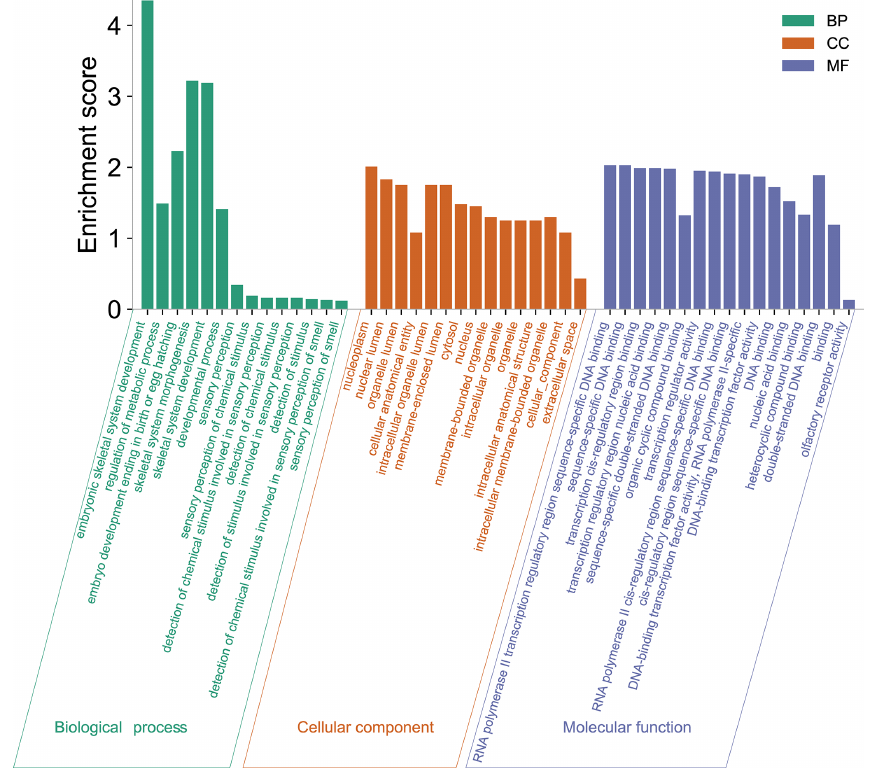
Figure 3. Functional classification of 755 positive selected genes across wild Asiatic mouflon sheep and domestic Hu sheep population. Green, orange, and purple represent the biological process, cellular component, and molecular function,